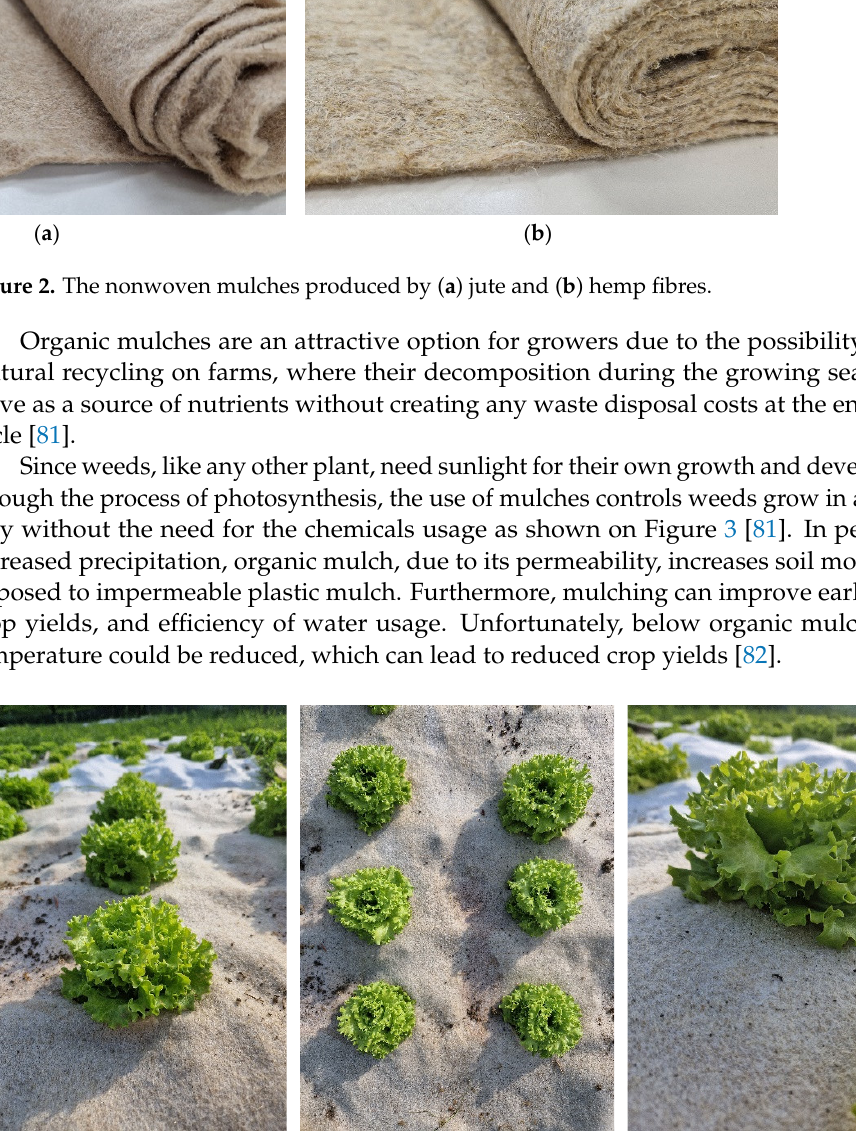
Figure 3. Protection from weed infestation by nonwoven mulches.